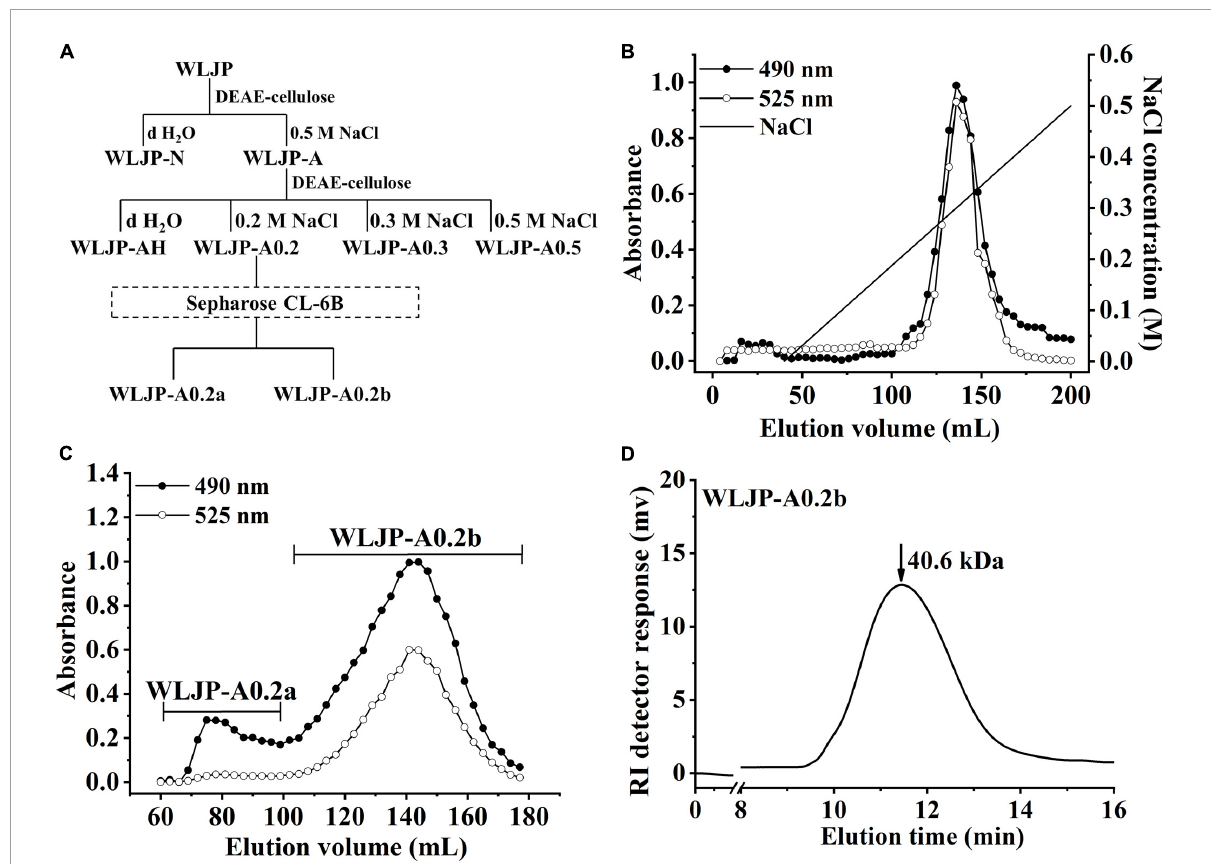
FIGURE1 Preparation of pectin from Lonicerae japonicae Thunb. (A) Fractionation scheme of WLJP by anion-exchange and size-exclusion chromatographies. (B) Linear gradient elution profile of WLJP-A on DEAE-cellulose column. (C) Elution profile of WLJP-A0.2 on Sepharose CL-6B column.